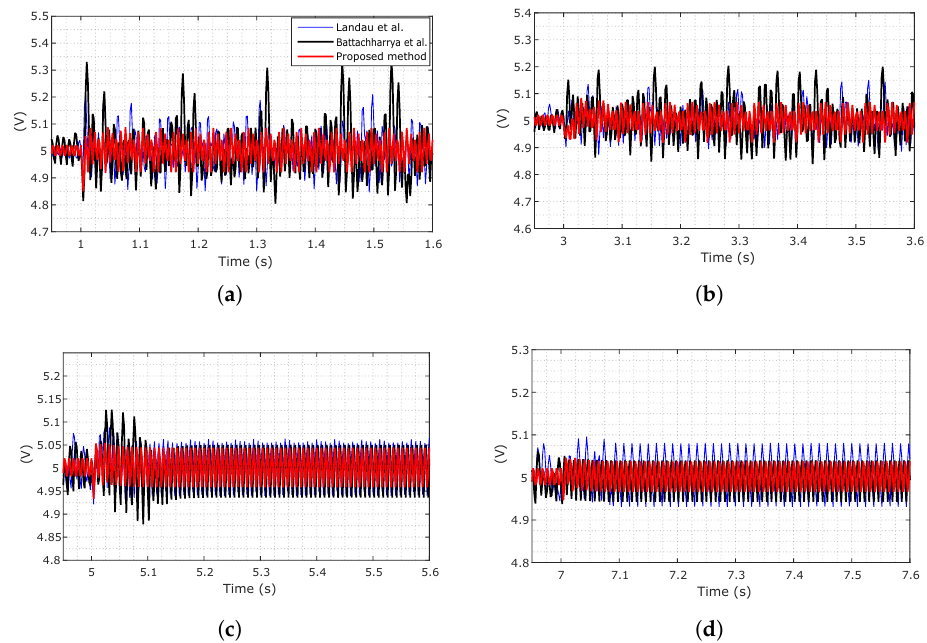
Figure 15. Zoom in simulation results of the output voltage when the system subject to a load variation. ( a ) R ref = 2.5 Ω ; ( b ) R ref = 3.0 Ω ; ( c ) R ref = 3.5 Ω ; ( d ) R ref = 4.0 Ω ;.